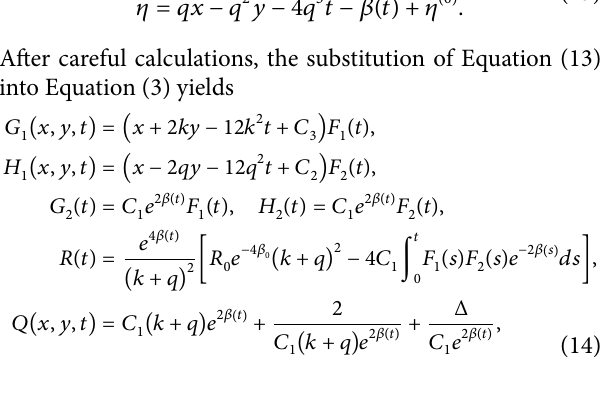
and 퐹 1 (푡) = 퐹 2 (푡) = 1, 훽(푡) = 푡, 푘 = 1/2, 푞 = −1/4, 휉 0 = 휁 0 = 푅 0 = 0 푡 = 0